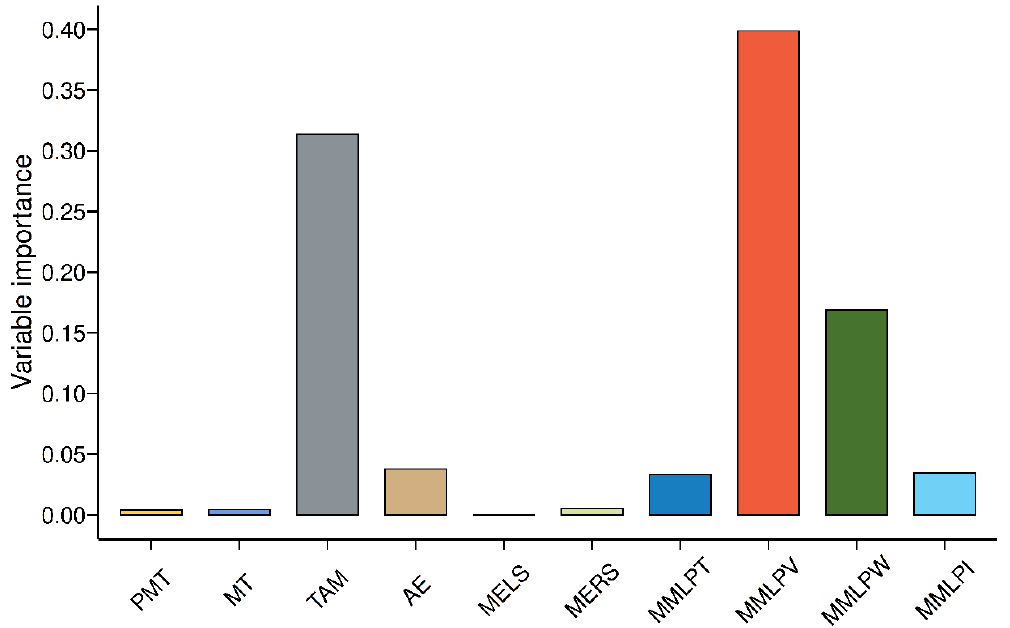
Figure 4. Variable importance measurement based on the RFT model for the Glutopeak test and mixograph results according to the addition of hazelnut skin. PMT = peak maximum time, MT = maximum torque, TAM = torque after maximum, AE = aggregation energy, MELS = mixograph envelope left slope, MERS = mixograph envelope right slope, MMLPT = mixograph MID line peak time, MMLPV = mixograph MID line peak value, MMLPW = mixograph MID line peak width, MMLPI = mixograph MID line peak